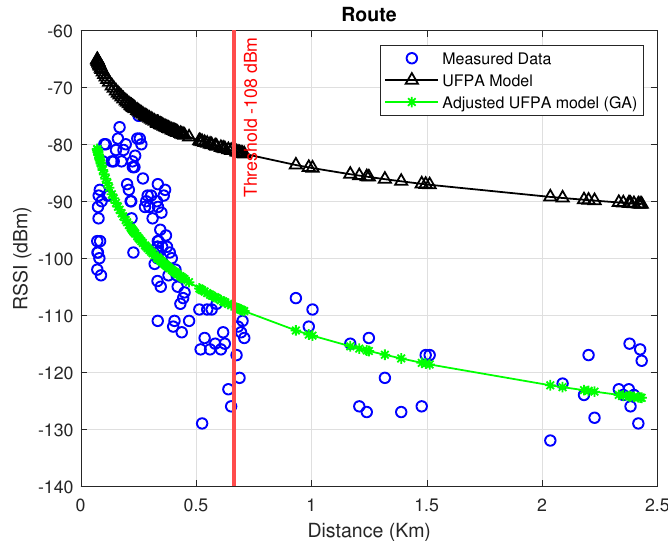
Figure 9. Comparison between measured data and models.